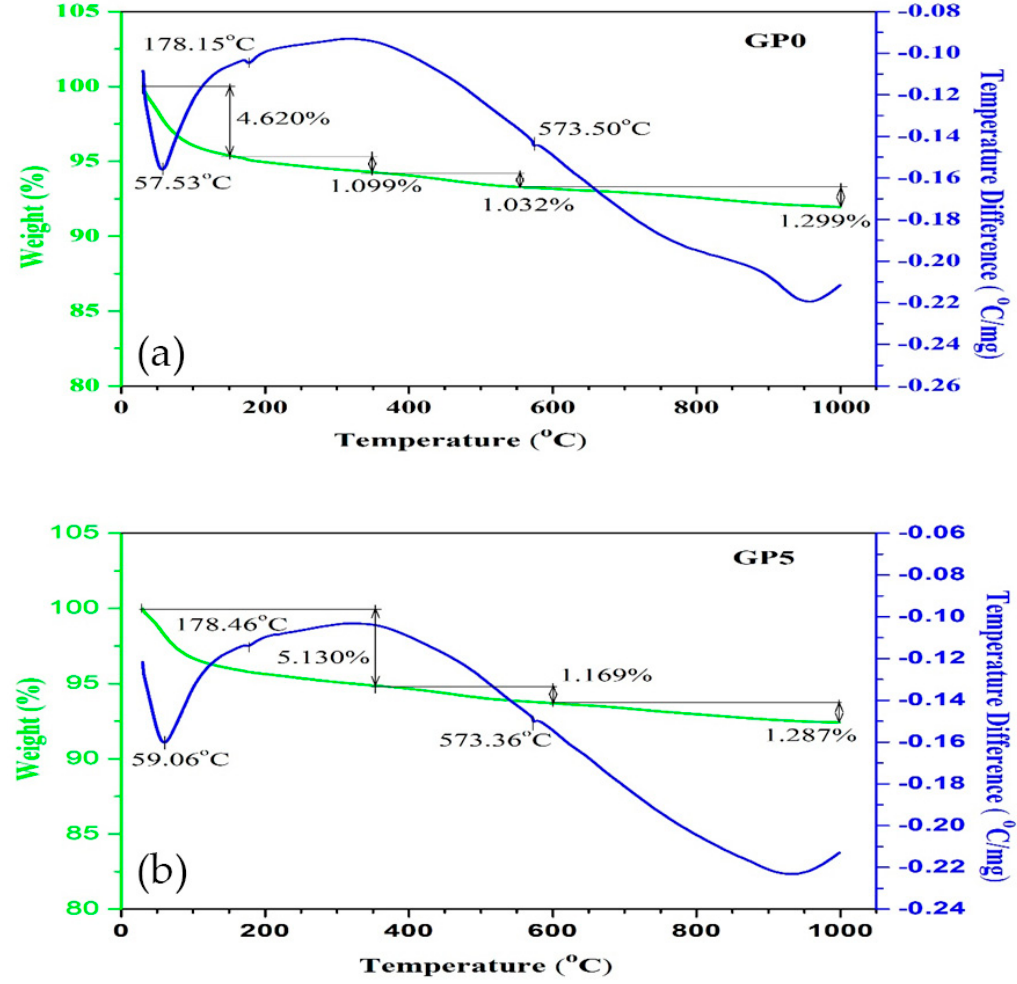
Figure 11. Thermal analysis (TGA-DTA): ( a ) Without PVA fiber; ( b ) with PVA fiber.